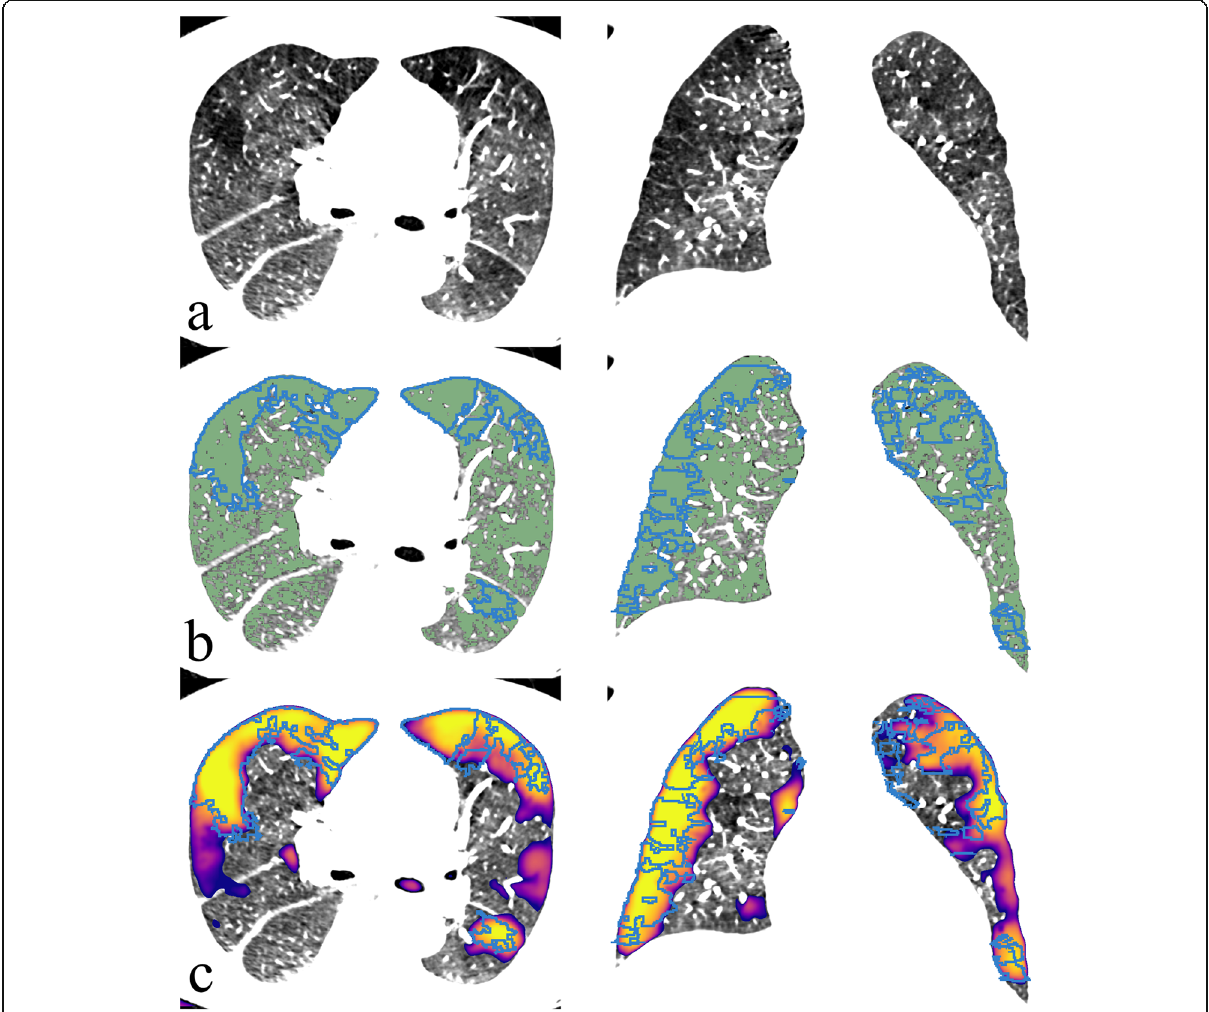
Fig. 4 An example case ( a ) of an overall low attenuation where a predefined HU-threshold ( ≤ -850 HU shown in green in b performs suboptimally compared to the convolutional neural network model ( c ) when compared to manual segmentation (blue outlines). HU Hounsfield